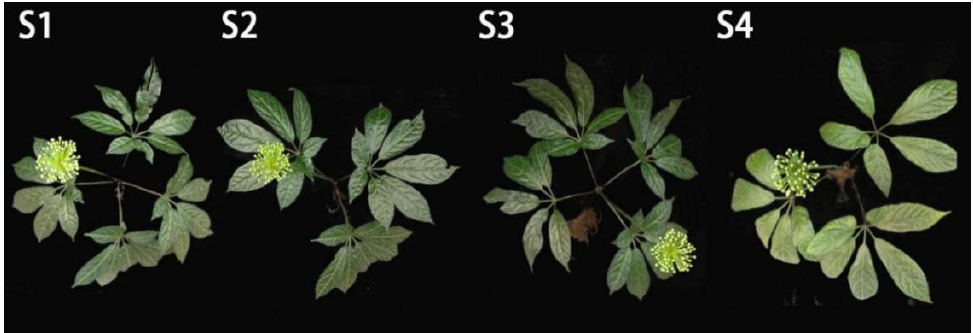
Figure 5. Morphological characteristics of flowers from different P. notoginseng varieties.